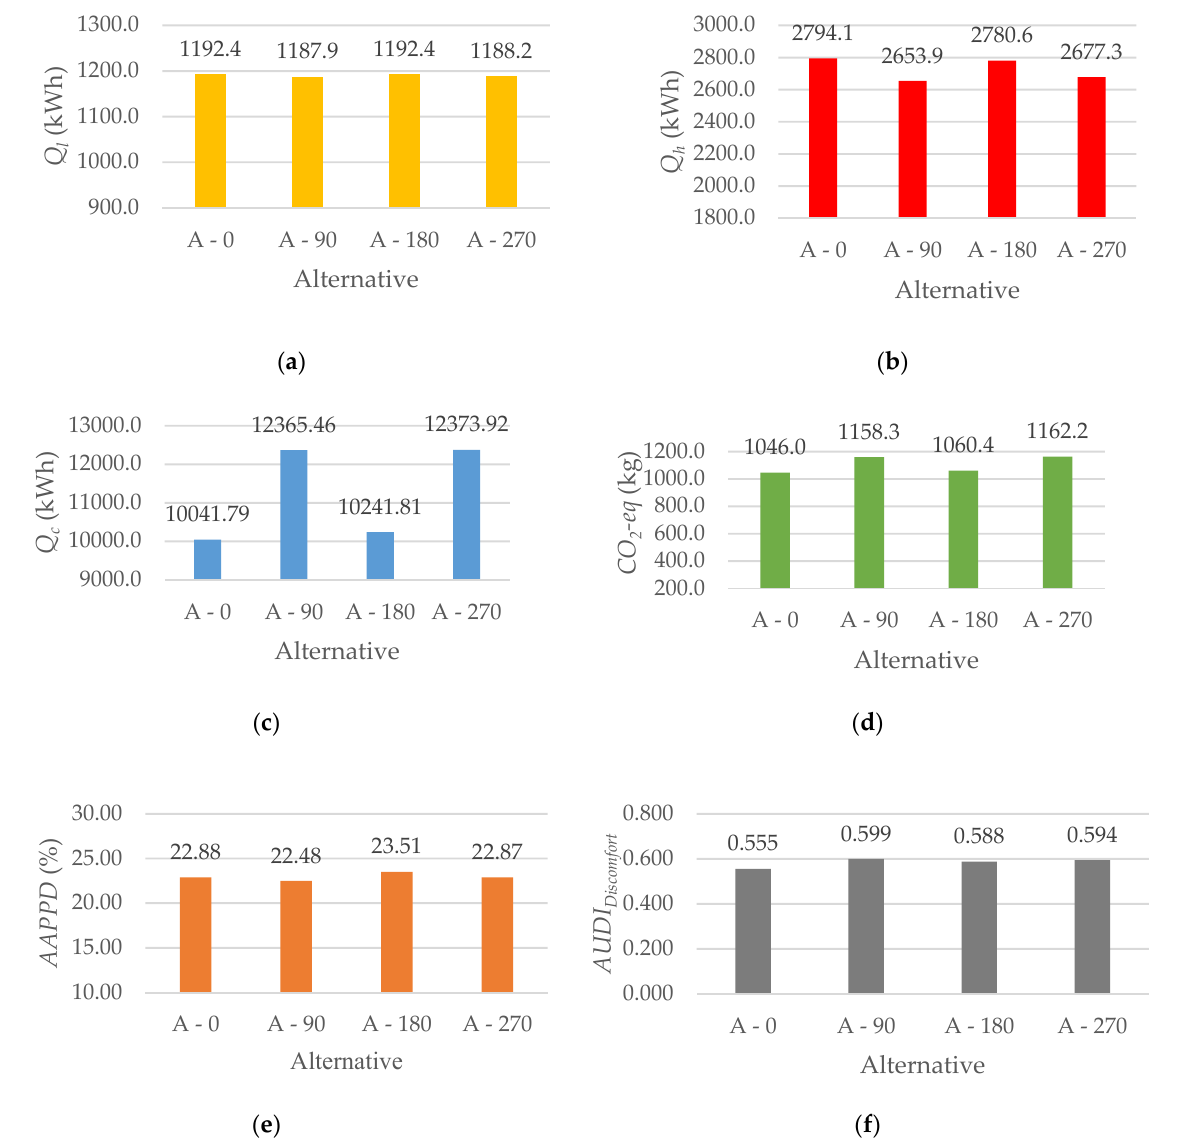
Figure 7. Annual profiles of the considered objective functions for different orientations of the building type A: ( a ) annual profiles of Q l ; ( b ) annual profiles of Q h ; ( c ) annual profiles of Q c ; ( d ) annual profiles of CO 2 -eq ; ( e ) annual profiles of AAPPD ; ( f ) annual profiles of AUDI Discomfort . Table 4. The TOPSIS results for different orientations of the building type A.